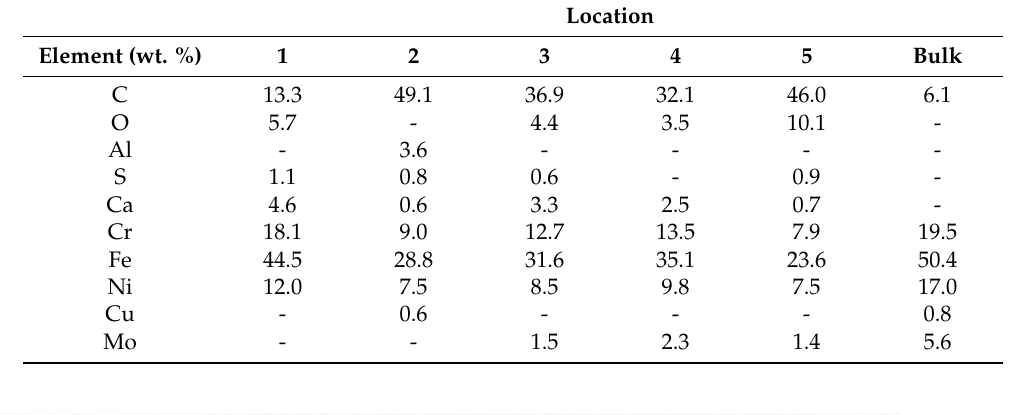
Table 9. EDX elemental analysis of locations shown in Figure 14. For comparison, an analysis of the bulk material after exposure at Reykjanes is included.